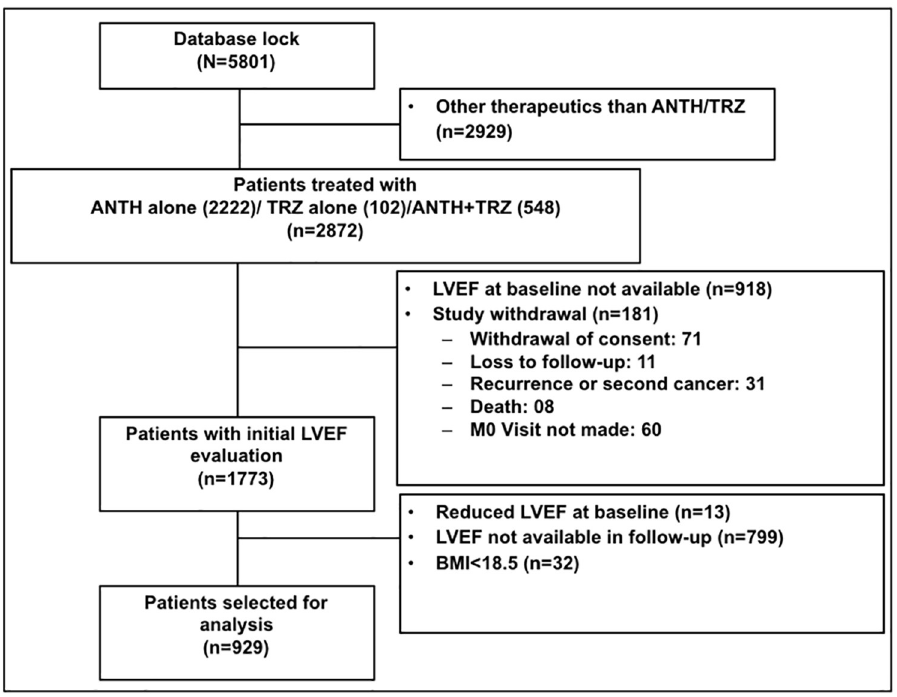
Fig 1. Flowchart. ANTH, anthracycline; LVEF, left ventricular ejection fraction; M0, month 0; TRZ, trastuzumab.